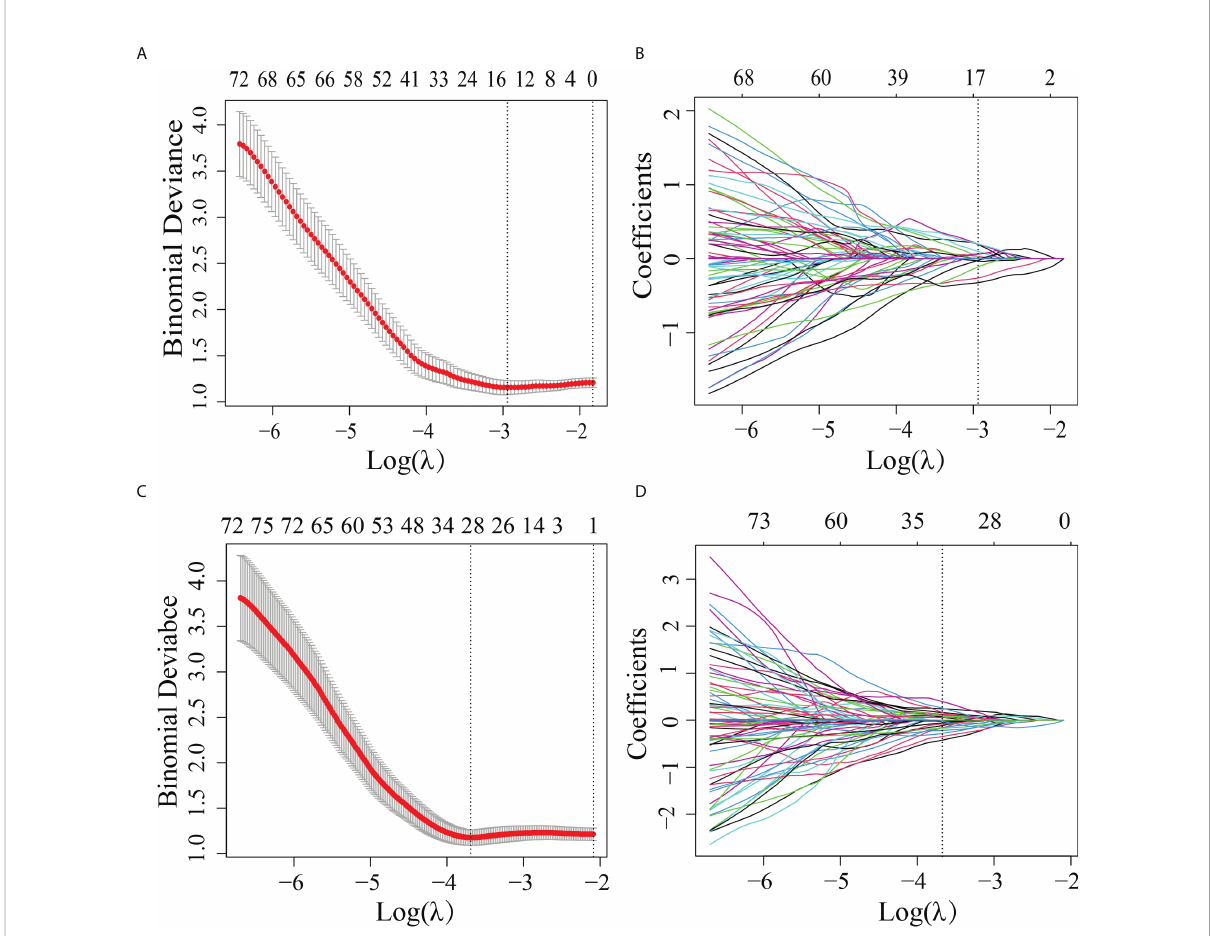
FIGURE 2 Features selected by the LASSO method. (A) Adjustment ( l ) selection by 10-fold cross-validation for the radiomics method. Binomial deviance (y-axis) was plotted log( l ) (x-axis). The dotted lines were drawn at the optimal value of l , where the model provided its best fi t. The optimal values of l and log( l ) were 0.0503 and -2.990, respectively. (B) Radiomics feature characteristics of the LASSO coef fi cient curve. The dashed vertical line was de fi ned with the optimal l , where 14 optimal radiomics features with nonzero coef fi cients are indicated. (C) Adjustment ( l ) selection by 10-fold cross-validation for the transfer learning method. Binomial deviance (y-axis) was plotted log( l )(x-axis). The dotted lines were drawn at the optimal value of l , where the model provided its best fi t. The optimal values of l and log( l ) were 0.0241 and -3.730, respectively. (D) Transfer learning feature characteristics of the LASSO coef fi cient curve. The dashed vertical line was de fi ned with the optimal l , where 28 optimal transfer learning features with nonzero coef fi cients are indicated.